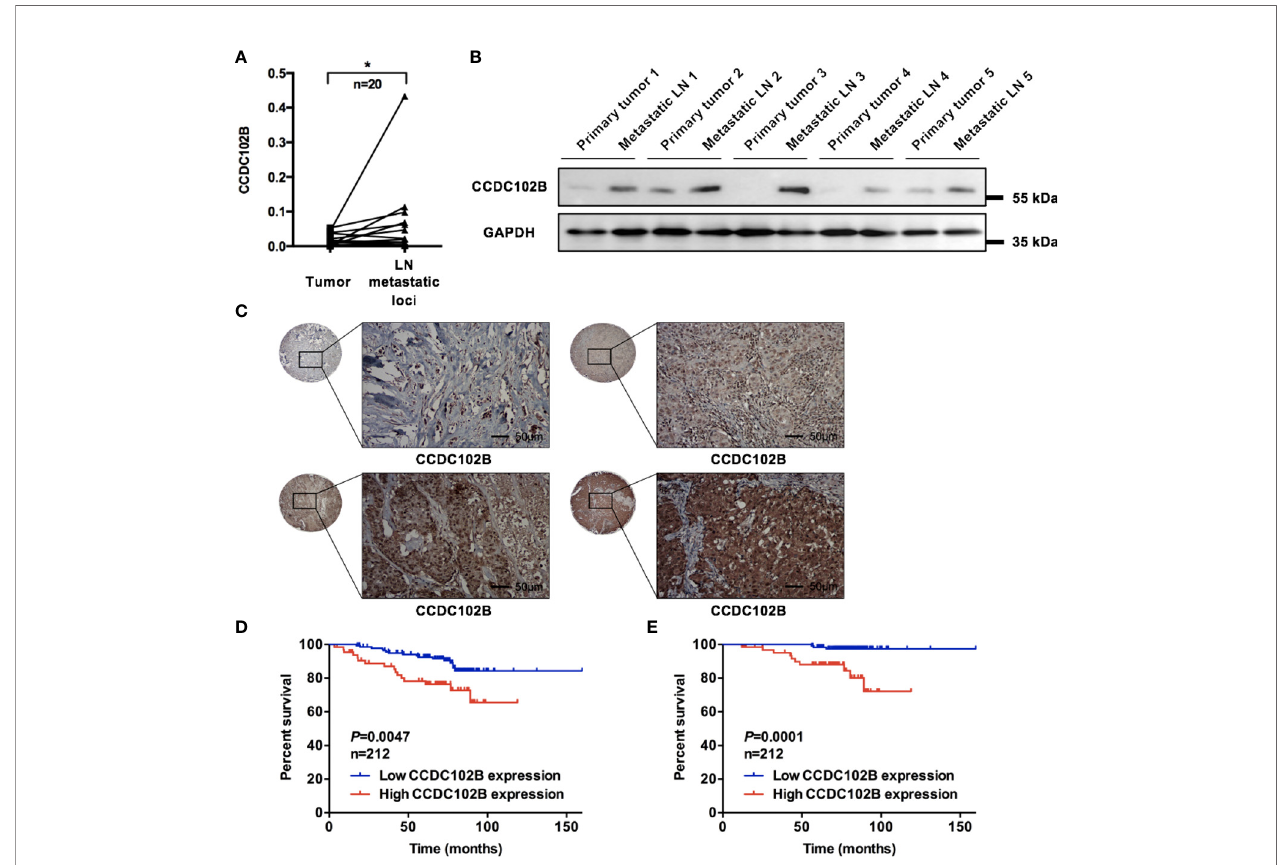
FIGURE 2 | Increased expression of CCDC102B correlates with poor clinical outcome. (A) Relative expression of CCDC102B in primary breast cancer tissues (tumor) and their corresponding LN metastatic loci in a 20-paired-sample cohort (Wilcoxon matched-pairs signed rank test). Normalized to b -ACTIN. (* P =0.011) (B) Expression of CCDC102B in primary tumors and corresponding metastatic LNs. (C) Breast tumor tissue microarray from 212 breast cancer patients using immunohistochemistry to determine CCDC102B expression. Scale bars: 50 m m. (D, E) Kaplan-Meier analysis and Log-rank test of recurrence-free survival (RFS) and overall survival (OS) with different expression of CCDC102B in breast cancer patients. *P ≤